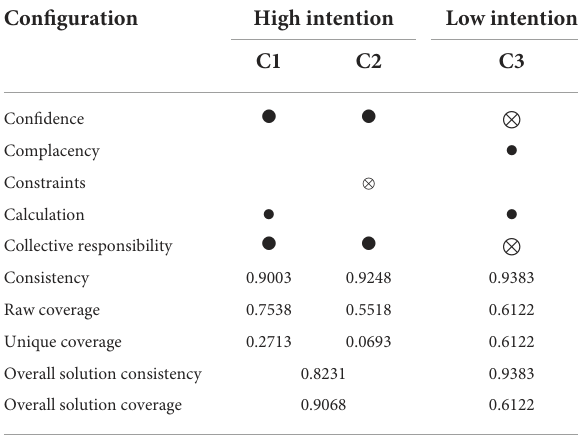
TABLE 5 Configuration of conditions for the third dose of COVID-19 vaccination